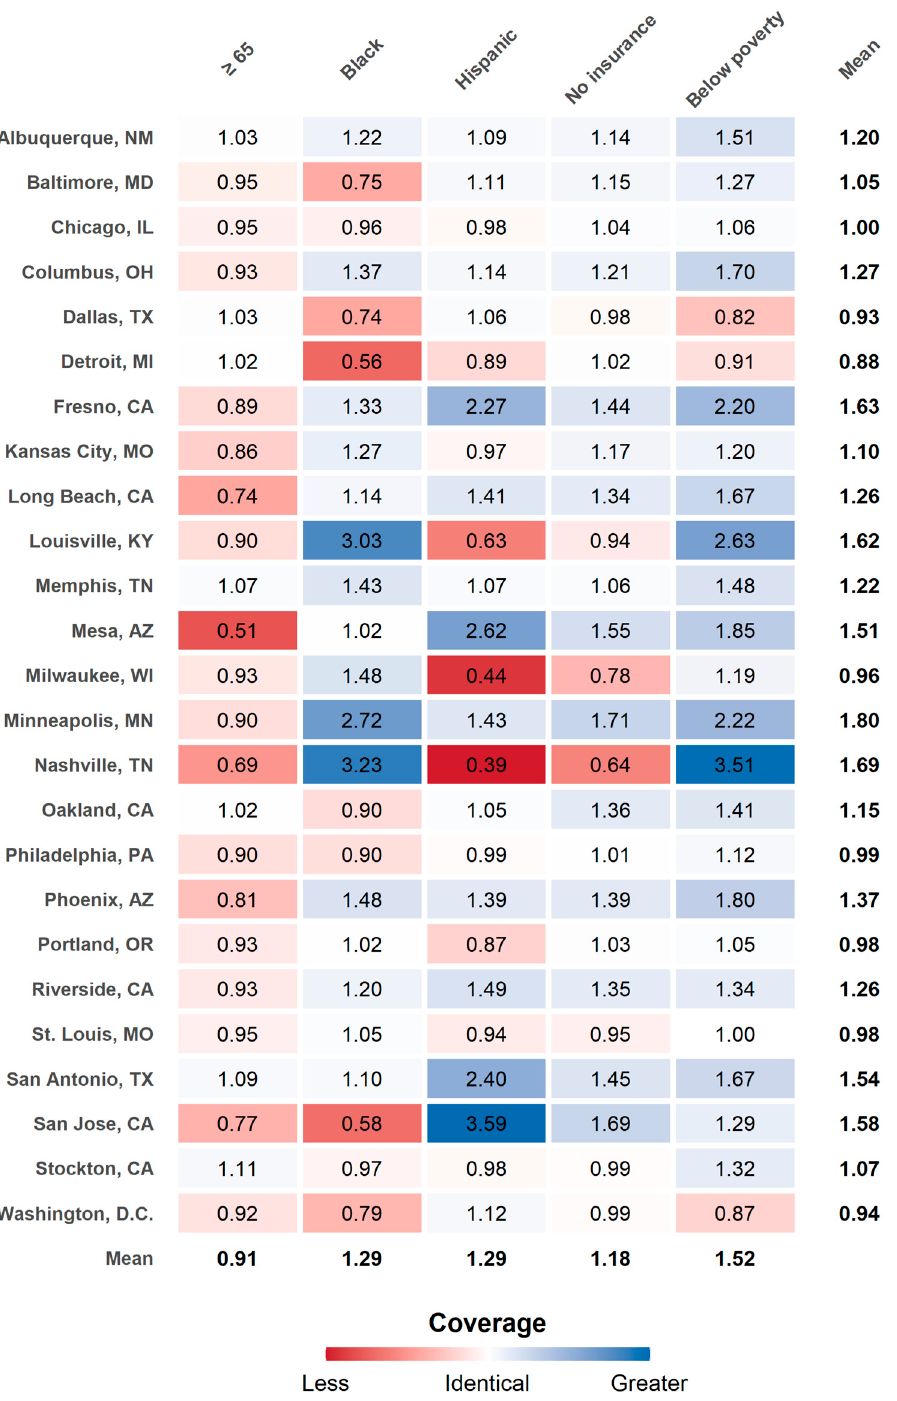
Figure 6. Subpopulation group comparisons with standardized population coverage ratios. Red and blue colors respectively represent less and greater service coverage for selected subpopulation groups compared to reference subpopulation groups.